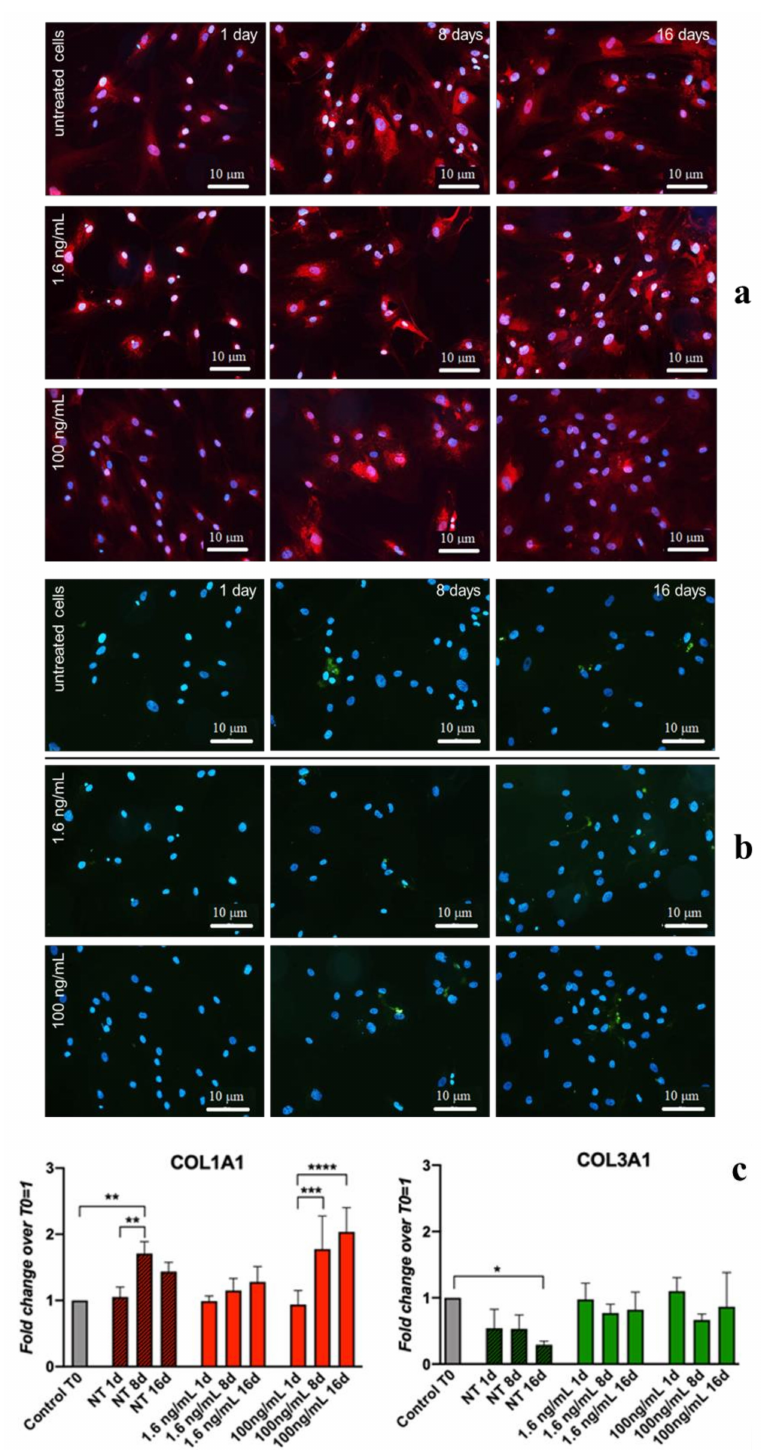
Figure 2. IF and quantitative-IF assays of type 1 Collagen (COL1A1) and type 3 Collagen (COL3A1) monitored along hBM-MSCs treatment with 1.6 ng / and 100 ng / mL of ihGDF-5 for 16 days. Type 1 collagen was stained in red; type 3 collagen was stained in green; cell nuclei highlighted with DAPI in blue ( a , b ). Quantitative signal detection was performed via ImageJ software ( c ). A slight up-regulation of COL1A1 was observed when hBM-MSC were in routine culture for 16 days. Color intensity in each time point was normalized by the cell number. * ≤ 0.05; * * < 0.01; *** < 0.005; **** < 0.001. n = 10 (image fields for each time